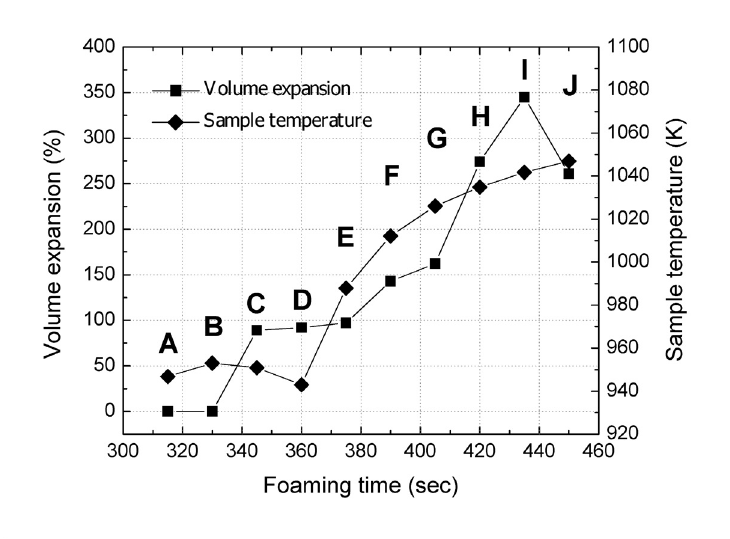
Figure 1. Foam expansion and sample temperature plots for interrupted